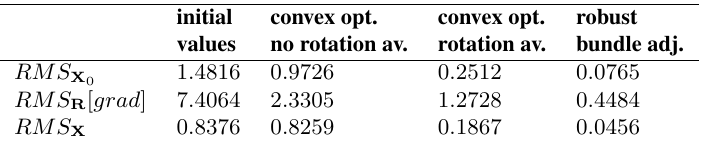
Table 1: RMS-values of the translation parameters X 0 , the rotations R (using (1)) and the object coordinates X for the three methods with respect to the ground truth.